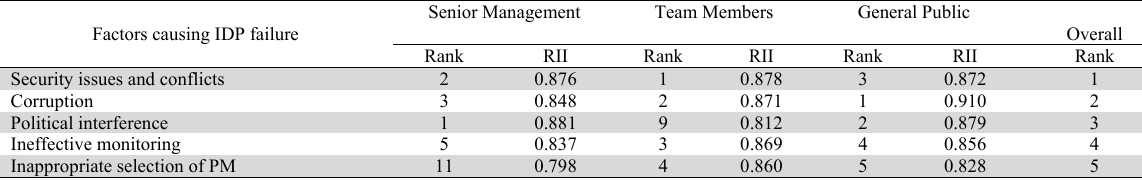
Five Top Overall-ranked IDP Failure